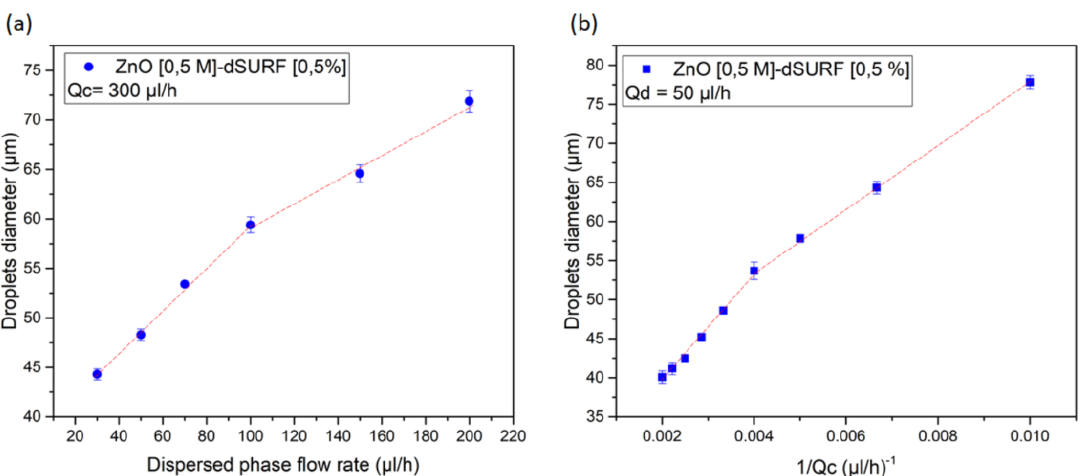
Figure 5. ( a ) Effect of the dispersed phase and ( b ) the continuous phase flow rates on the mean diameter of the generated droplets at a flow rate of the continuous and dispersed phases equal to Q c = 300 µ L/h and Q d = 50 µ L/h,